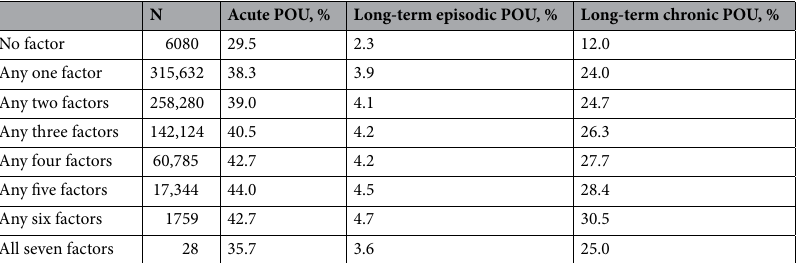
Table 3. Prescription opioid use by number of social vulnerability factors (non-white race, females, homelessness, poverty income < $45,200, rural or highly rural residence, alcohol use disorder, psychiatric illness). POU, prescription opioid